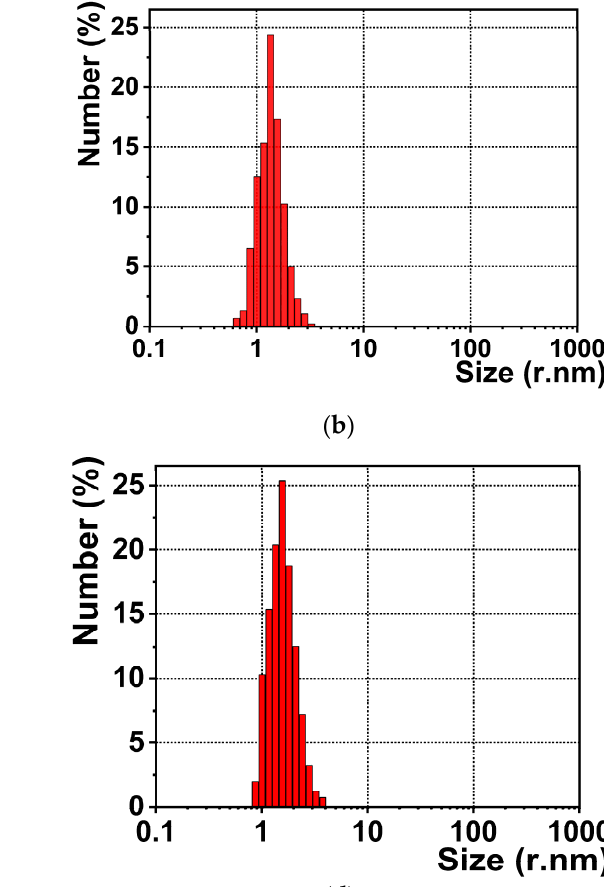
Figure 5. ( a ) Fluorescent emission of Pep-CuNCs in the presence of various concentration of Pb(II)